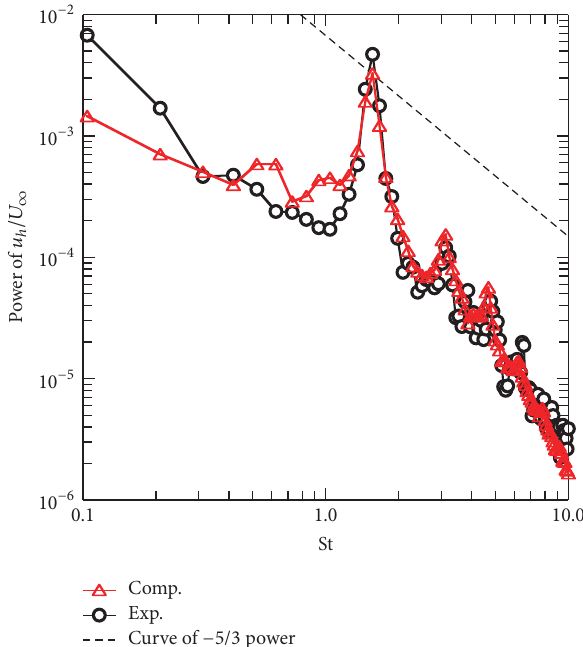
Figure 8: Predicted and measured power spectra of velocity fluctuations ( 𝑥/𝐿 = 0.5 and 𝑦/𝐿 = 0.02) for cavity flow with 𝐷/𝐿 = 0.5.